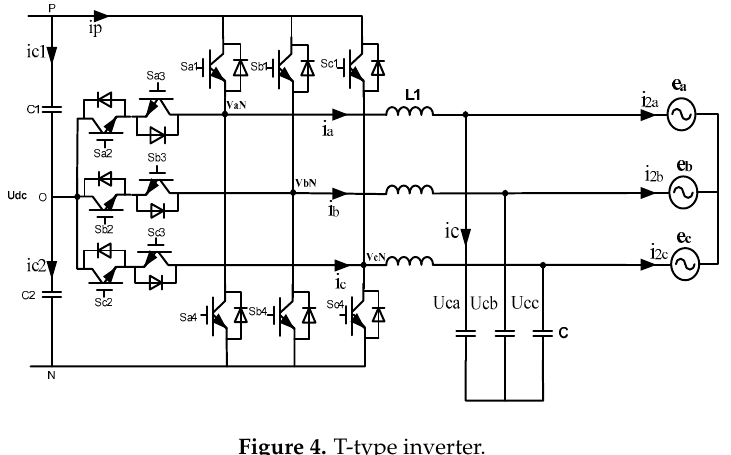
Figure 4. T-type inverter.